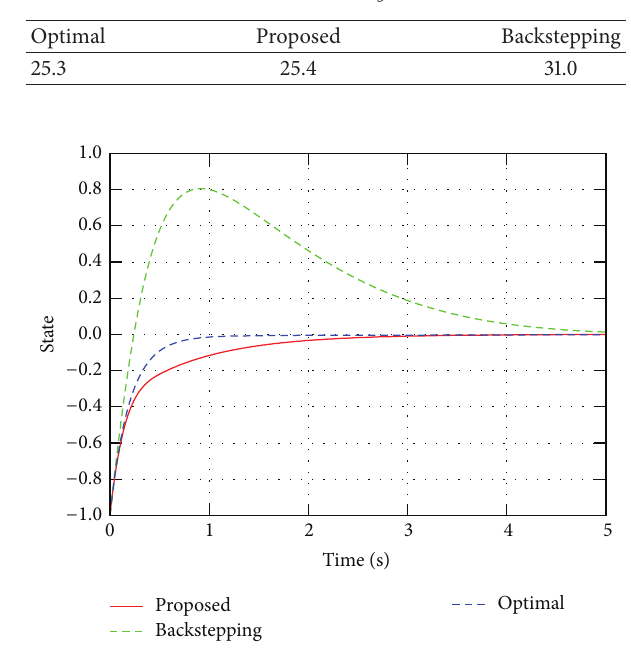
Figure 1: Time histories of 𝑥 1 (𝑡) .